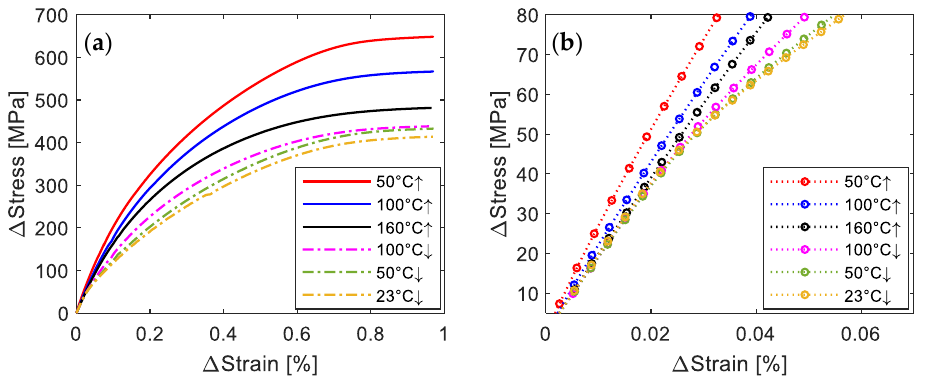
Figure 11. ( a ) Representative ∆ stress- ∆ strain curves during loading to 1%. The initial ∆ stress/ ∆ strain is set to be zero. ( b ) The experimental data in the stress range of 5–80 MPa.